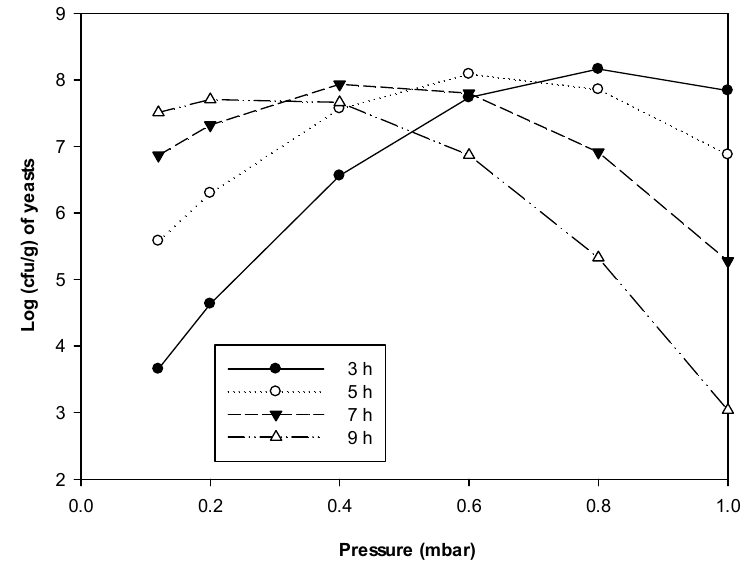
Figure 6. Predicted log (cfu/g) of yeasts of dried MKG at different freezing times and pressures. 280 The experimental and predicted log (cfu/g) values of yeasts of dried MKG are shown in Table 4. The 281